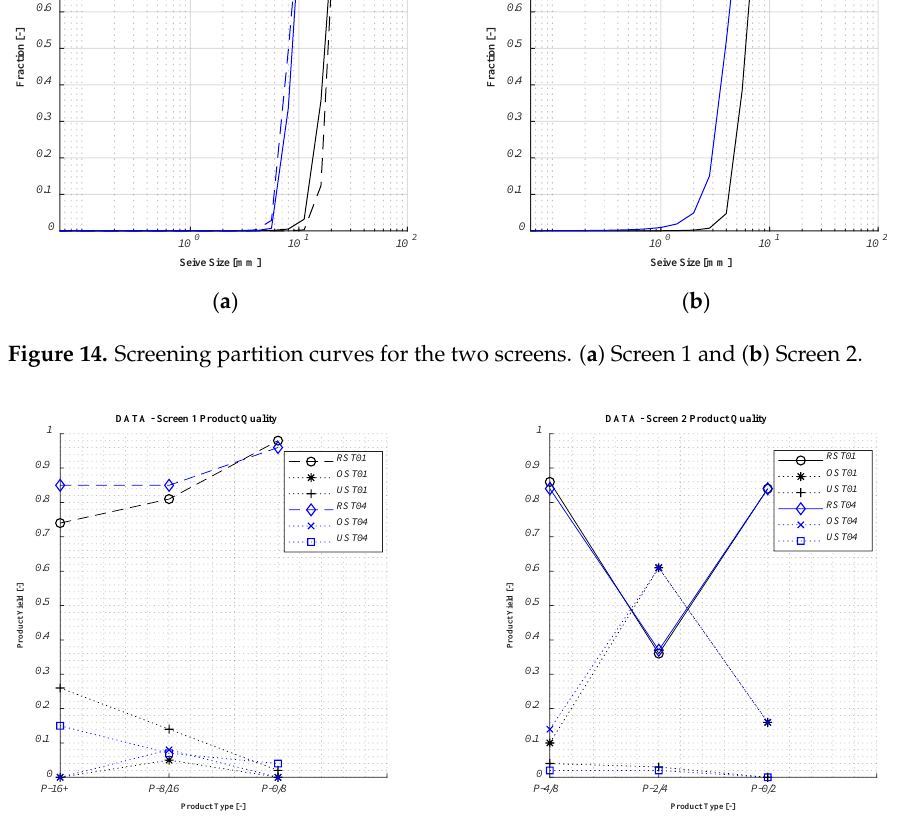
Minerals 2021 , 11 , 921 13 of 19